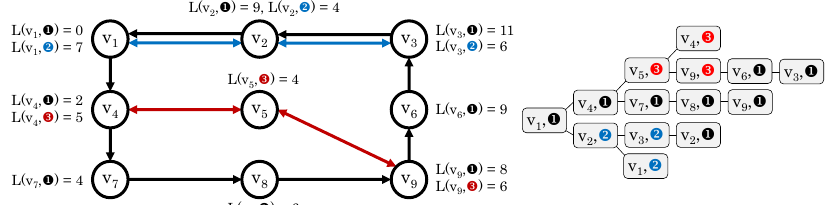
Figure 5. Solution returned by E XTENDED -D IJKSTRA -V1 using the graph from Figure 2 and source ( v 1 ,1 ) . All transfer penalties are assumed to be 1. The shortest path tree rooted at ( v 1 ,1 ) is defined by the contents of P and is illustrated on the